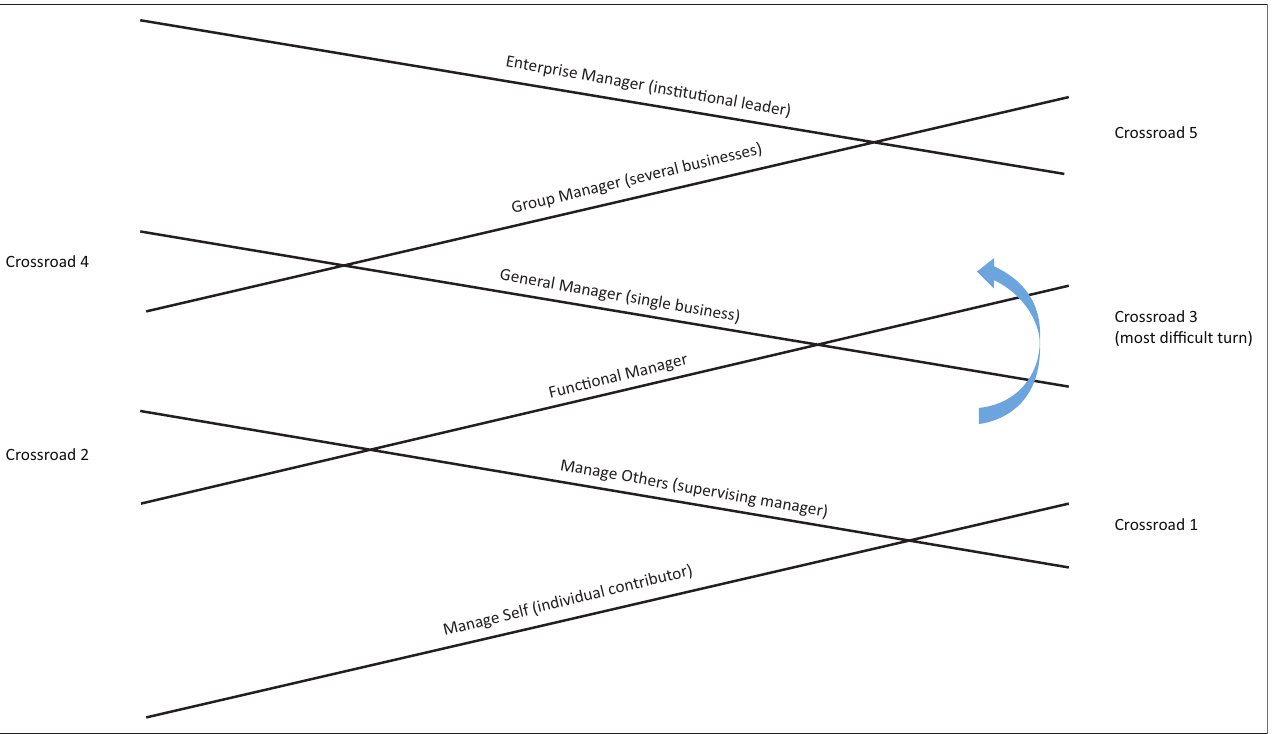
FIGURE 1: The six primary pathways and five basic career